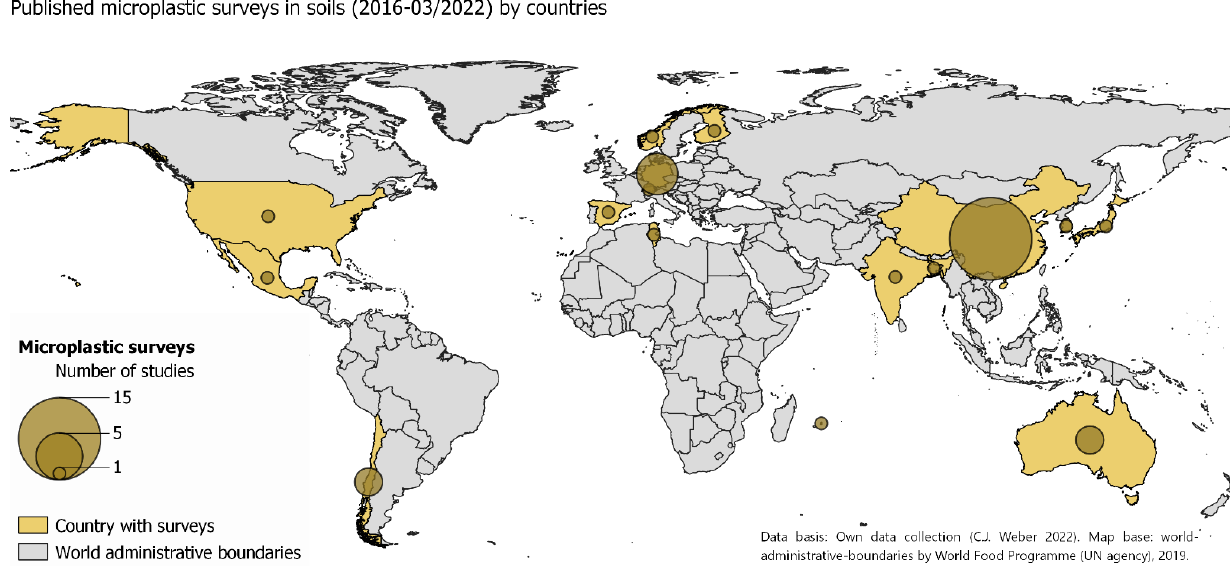
Figure 2. Worldwide map of existing (as of March 2022) studies reporting (micro-)plastic evidence in soils. Table 2. Evaluated studies and their respective country of implementation as well as region and reference data.